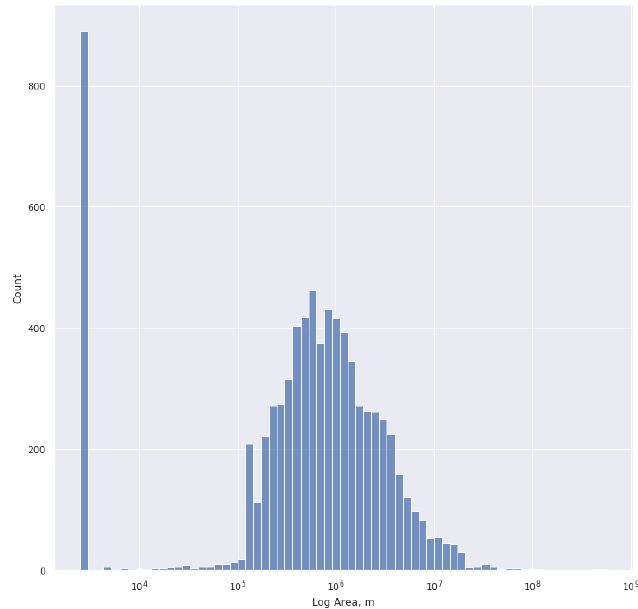
Figure 9. Histogram of the number of recognized lakes on images from Alaska vs the log of lake size